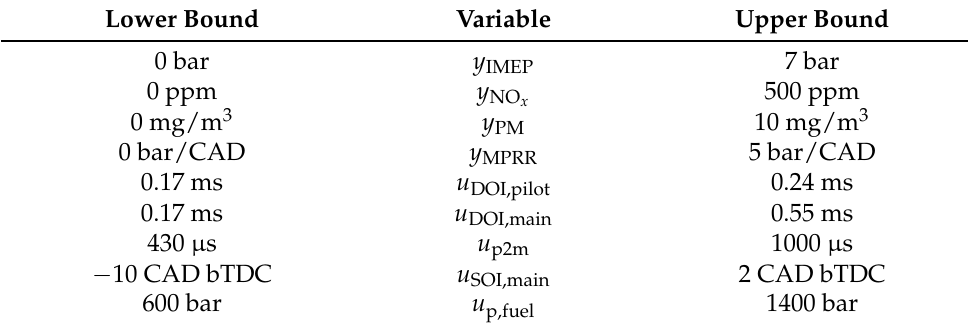
Table 4. Constraint